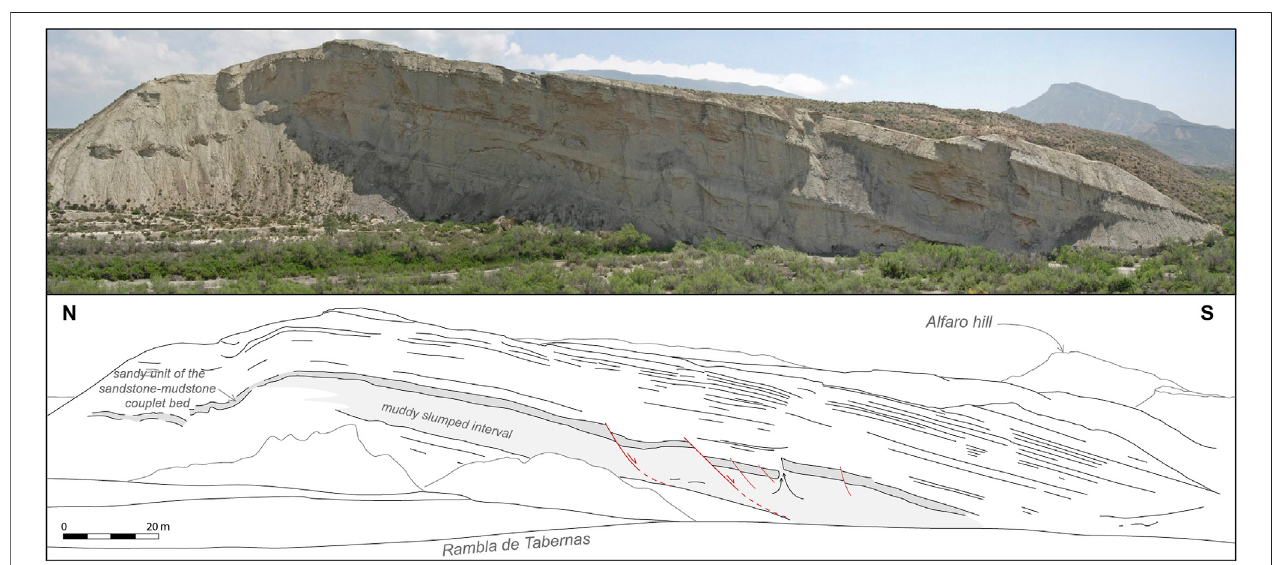
FIGURE 6 | Photograph and line drawing of part of Phase 3 succession due north of the Alfaro sub-basin in the Rambla de Tabernas (see Figure 2 for location). Note the irregular thickness ofthesandstone-mudstonecouplet (highlighted indark grey)deposited above a fi ne-grained slumped interval. Early listricfaults(highlighted in red) locally intruded by mobile water saturated marls and rooting at the base of the slumped interval are also developed.